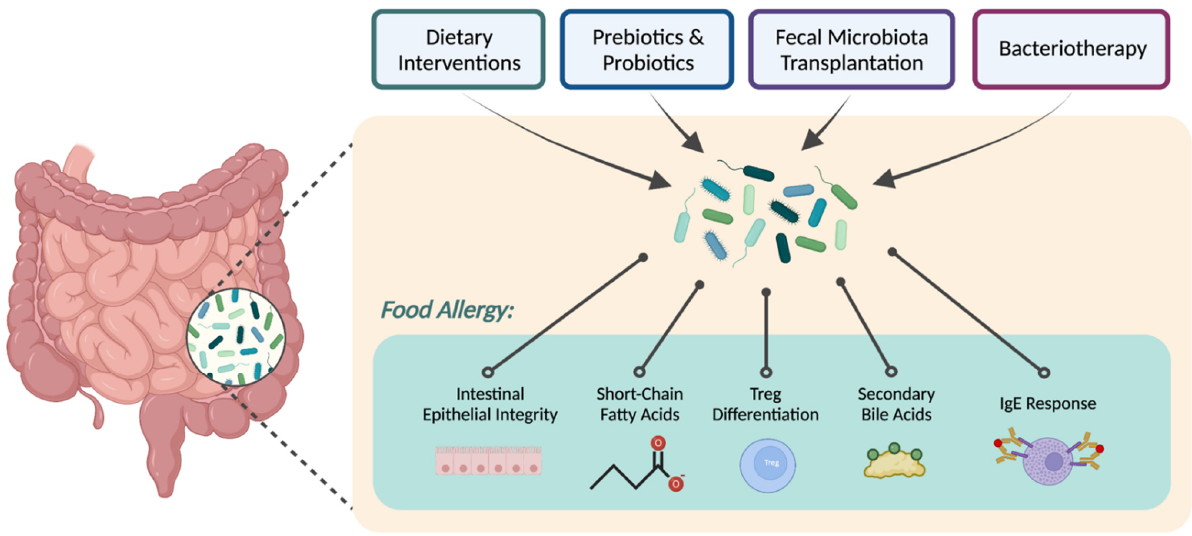
Figure 1. Outline of microbiome-related therapeutic strategies for food allergies.